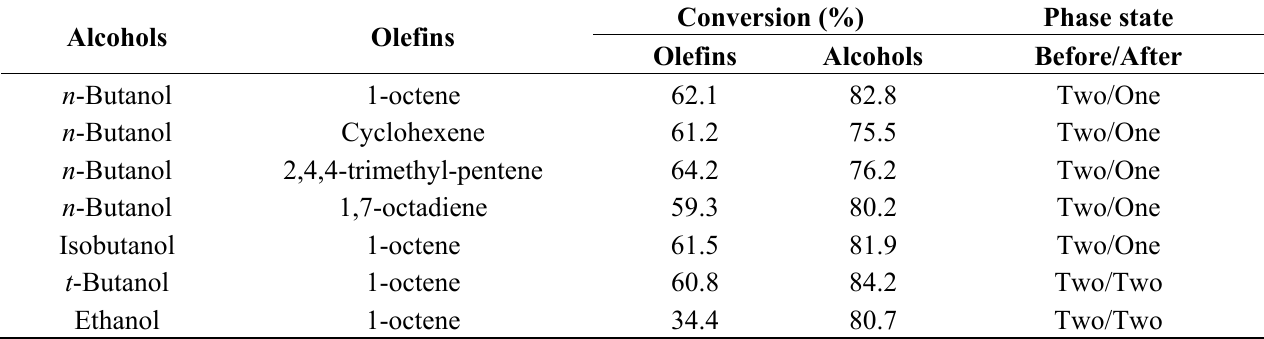
Table 2. Upgrading bio-oil over SSA with different alcohols and olefins at 120 °C for 3 h a .